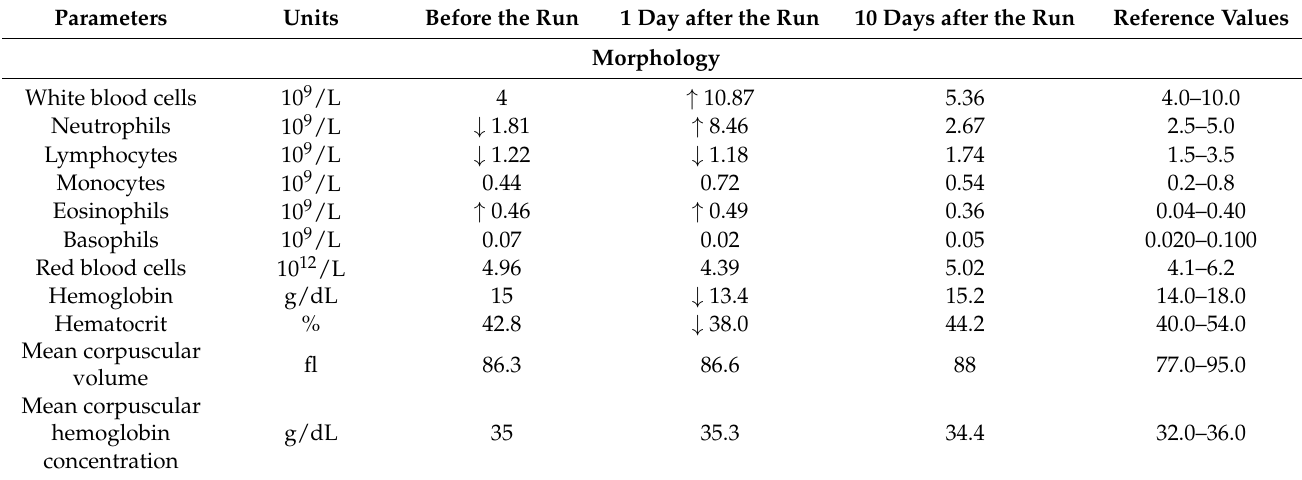
Table 3. Summary results of blood tests.